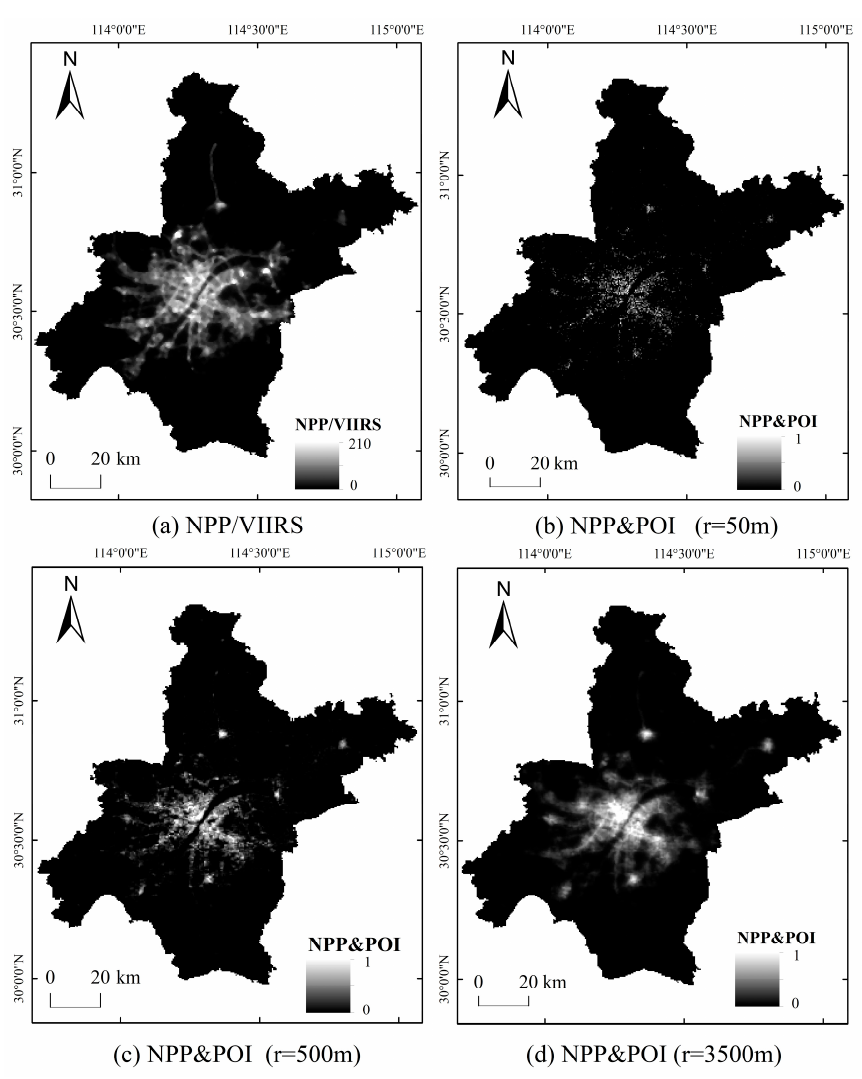
Figure 2. Comparison of NPP and POI processing effects in Wuhan under different search dis- tances.